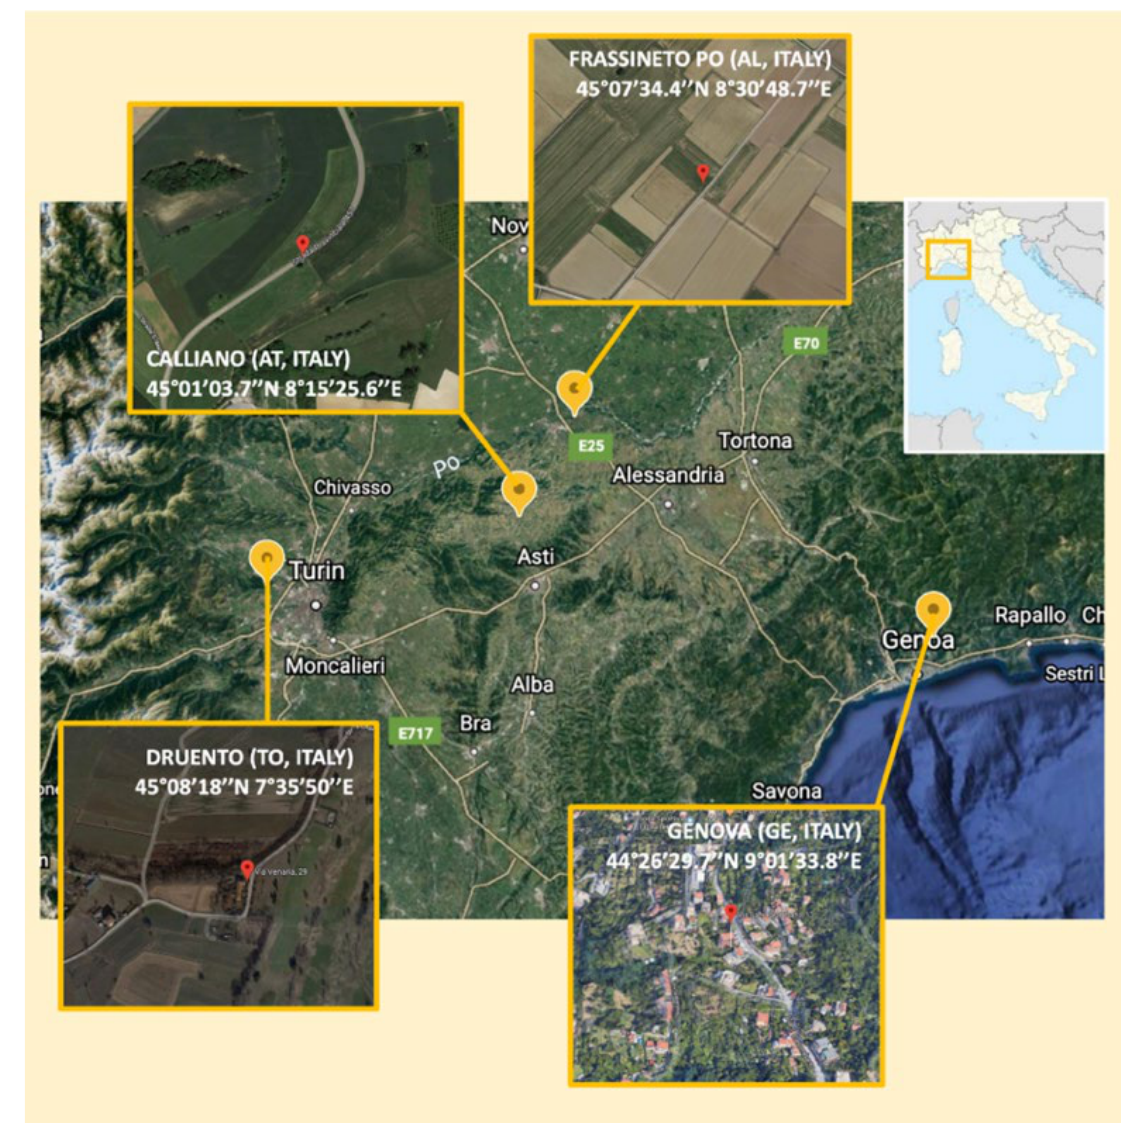
Figure 1. View of the sampling map. The image was produced using Google Earth's online version. Roots of pea and fava bean (3 plants in each considered site) were harvested and washed with tap water. Nodules were separated from roots with a sterile scalpel and placed in a 50 mL sterile tube to which 30 mL of sterile deionized water was added for 15 min, under slow shaking. This procedure was repeated 4 times to reduce bacterial density on the nodule surface. Then, the nodules were surface sterilized in 1% sodium hypochlorite for 5 min. Next, 5 more washing steps (1 min each) were performed in sterile physiological solution (NaCl 0.9%). To check the nodule surface sterilization efficacy, 5 nodules per sample were incubated on Trypticase Soy Agar (VWR, Milan, Italy) for 5 days at 28 °C. Nodules were then homogenized in 10 mL of MgSO 4 , 0.1 M, with a Tissue Lyser at 560 rpm for 5 min. Finally, 100 µL of the suspension was spread, in triplicate, onto Yeast Mannitol Agar (YMA) plates added with cycloheximide (100 µg mL −1 ) (Sigma Aldrich, Milan, Italy) [24]. This growth medium is widely accepted as selective for nitrogen-fixing bacteria.